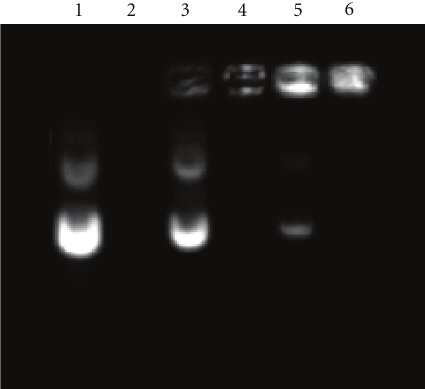
Figure 5: Electrophoretic mobility analysis NP/DNA complexes